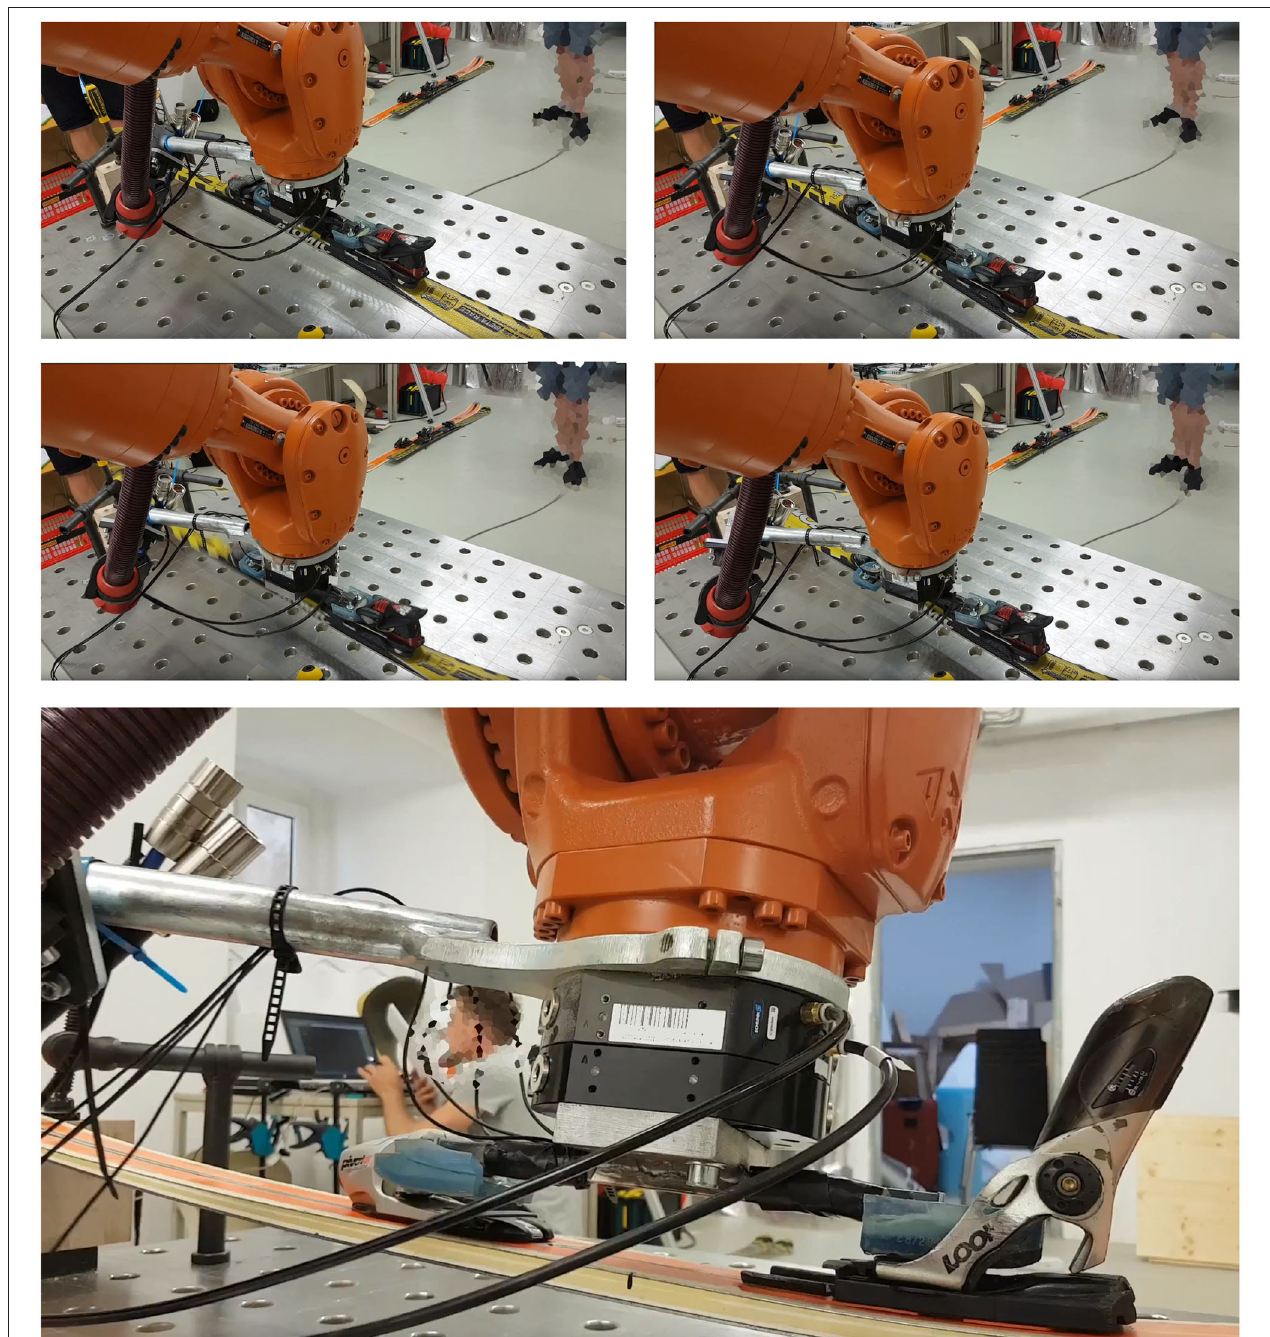
FIGURE 3 | Photo sequence of an inclined back-weighted toe piece release situation: Top left: Ski in starting position (ski rests on supports without any inclination). Top right: Ski is deflected in negative z-direction. Mid left: Rotation around the y-axis to adumbrate skier’s layback. Mid right: Toe piece release. Bottom: Toe piece release from zoomed side